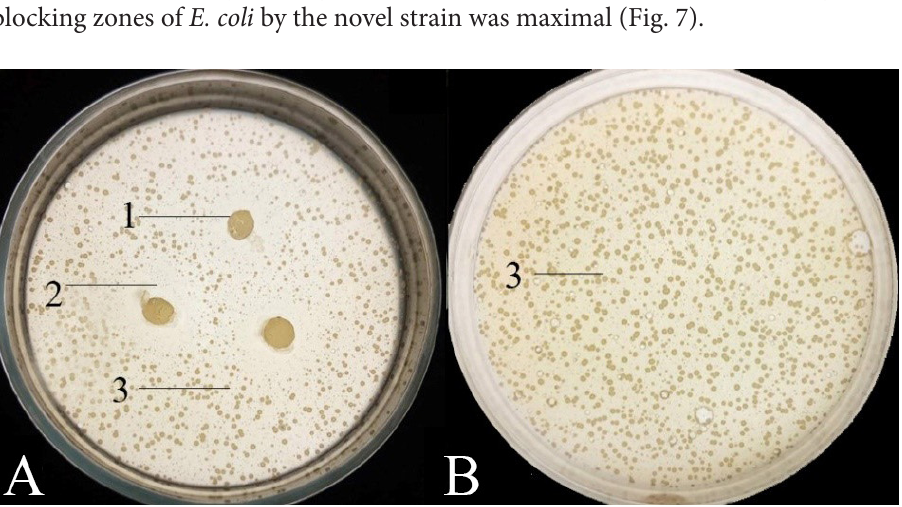
Figure 7. Antagonistic activity of B. pumilus 16 against E. coli . A – Plate with agar blocks. B – Control plate. 1 . Block with antagonist strain. 2 . The zone of growth inhibition. 3 . Test